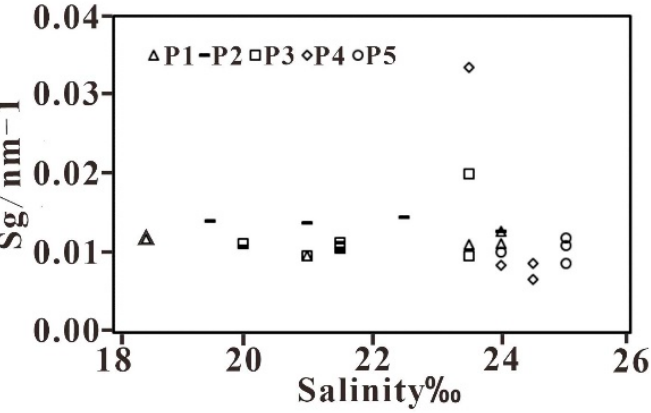
Figure 13. The relationship between Sg and salinity along the five transects.